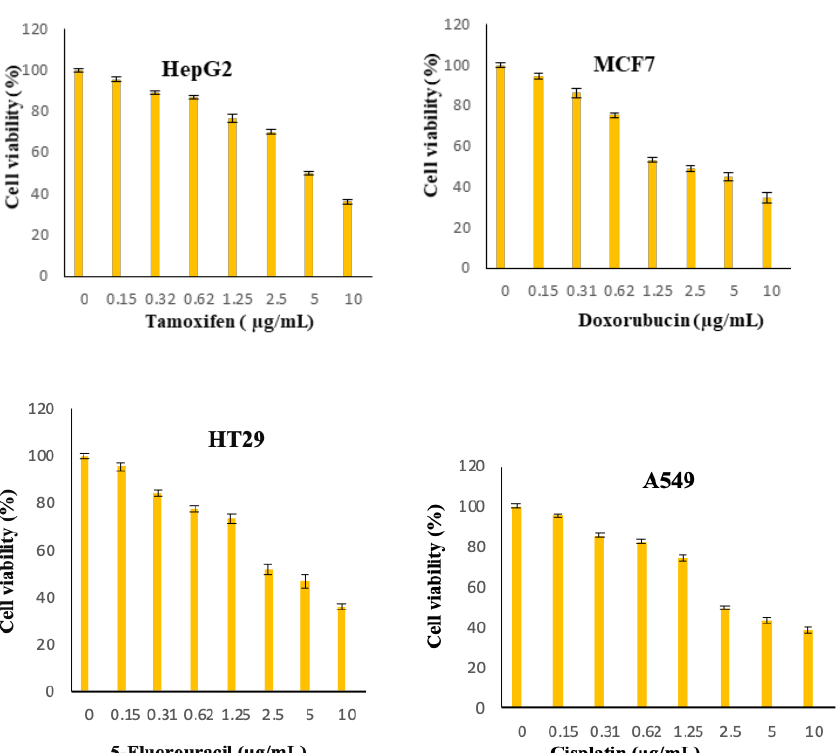
Figure 11. Chemotherapeutic effects on the viability of treated cells (MCF7, HepG2, A549, and HT29) using MTT assay after 24 h.